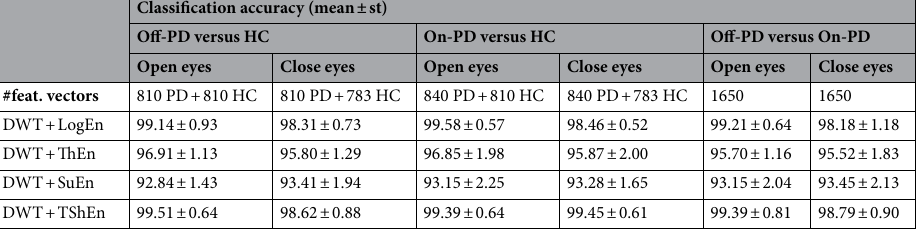
Table 11. Classification results using SVM classifier (UNM dataset).